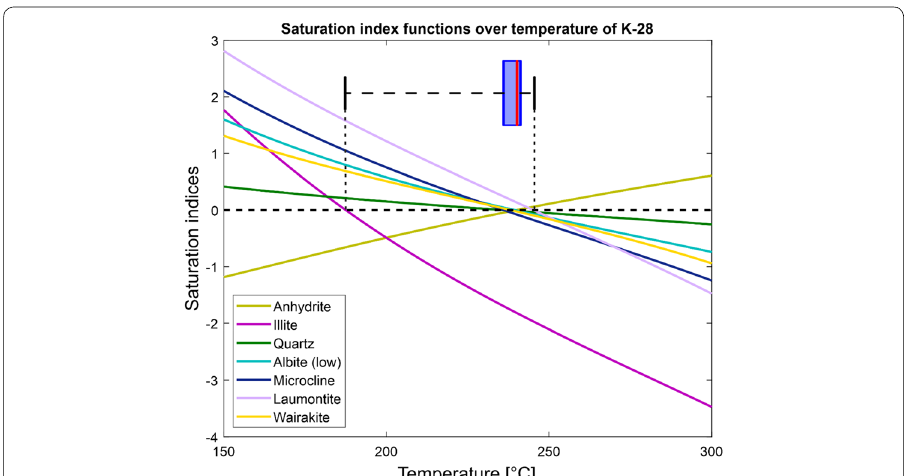
Fig. 1 Example of the creation of an equilibrium temperature distribution box plot via the saturation indices over the temperature [°C] of the basalt-specific mineral phases for sample K-28. The box plot includes the temperature values of each mineral where SI 0 (intersection of the saturation index of a mineral phase and = the equilibrium